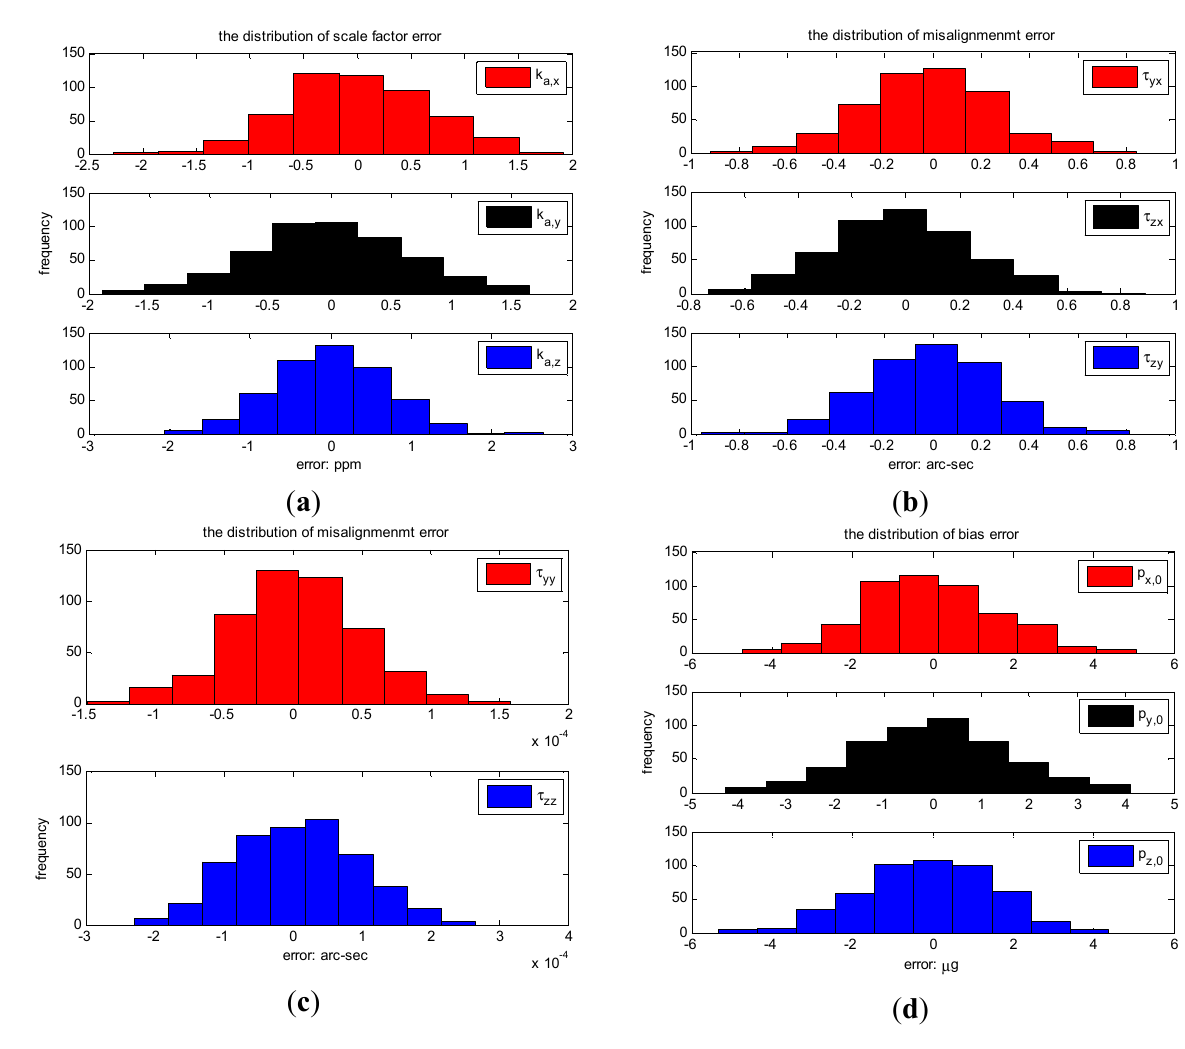
Figure 3. Error distributions: ( a ) scale factor errors. ( b ) the first set of misalignment errors. ( c ) the second set of misalignment errors. ( d ) bias errors. ( e ) squared coefficient errors. ( f ) inclination vector estimation